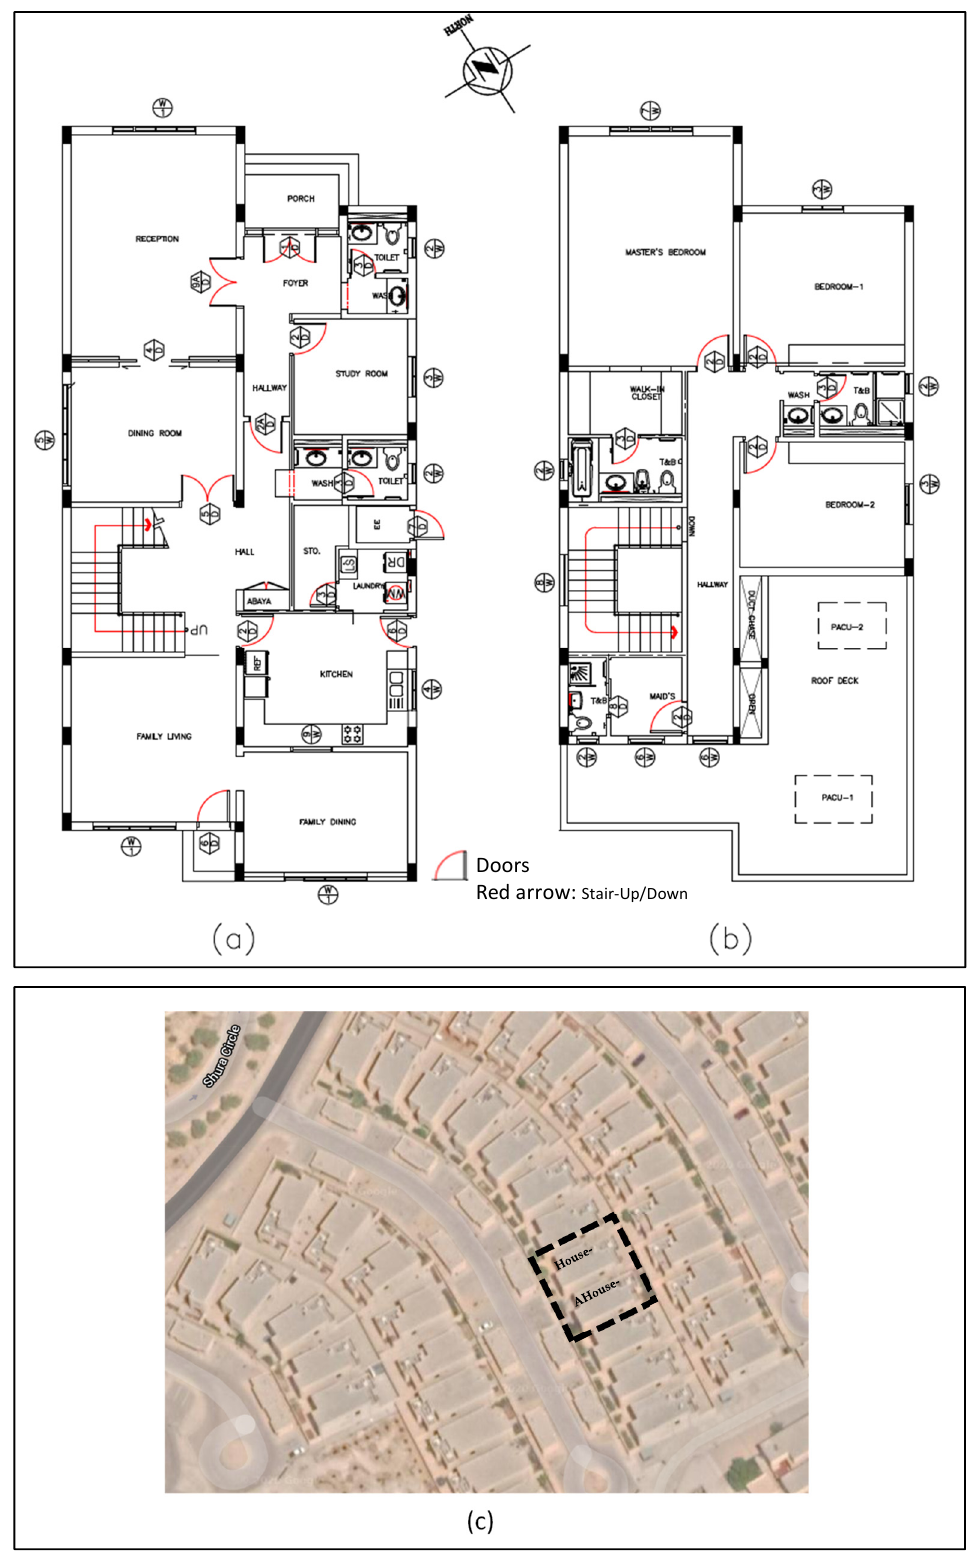
Figure 6. ( a ) Ground floor plan, ( b ) first-floor plan, and ( c ) buildings’ surroundings. The HVAC system type used in the two houses is a constant-volume (CV) direct expansion package unit, in which a unit serves each floor. The total cooling capacity and supply airflow for the ground floor unit were 40.7 kW (139.8 MBTUH) and 8121.3 m 3